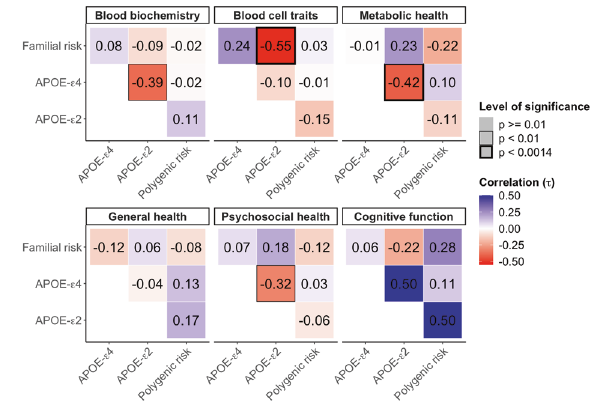
Fig. 2 Correlations between the trait association results of different forms of AD genetic risk. The value reported in each cell is the rank correlation coef fi cient (Kendall ’ s τ ) between the genetic-trait association results, illustrated in Fig. 1, of the corresponding forms of genetic risk. All the results are adjusted for age, age 2 , sex, age*sex interaction term, socioeconomic status based on Townsend deprivation index, genotyping batch, assess- ment centre, and the fi rst 12 principal components of ancestry, self- reported CVD, statin use, parental CVD and lifestyle score (see Methods). Correlations of nominal signi fi cance ( P < 0.01) are high- lighted by a box, while those that are signi fi cant after correction for multiple testing ( P < 0.0014; see Methods) are highlighted by a bold